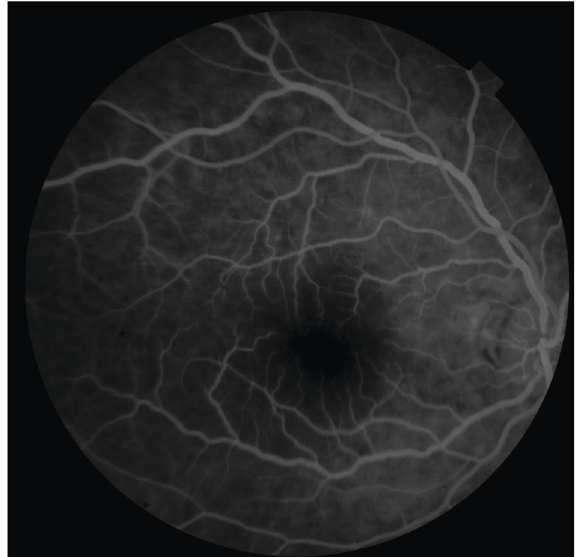
Figure 2: Preoperative low retinal perfusion in the right eye.